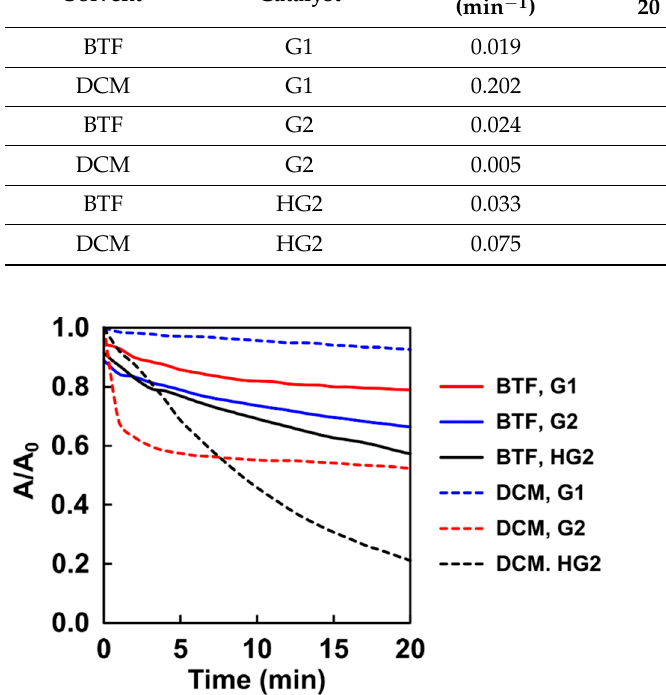
Table 3. The solvent, the catalyst, rate constant, and the conversions after 20 min and 24 h in the ring-closing metathesis reactions of diethyl 2,2-diallylmalonate (c 0 = 35.6 mM) in benzotrifluoride (BTF) and dichloromethane (DCM) using 1 mol% G1, G2, or HG2 as catalysts. Solvent